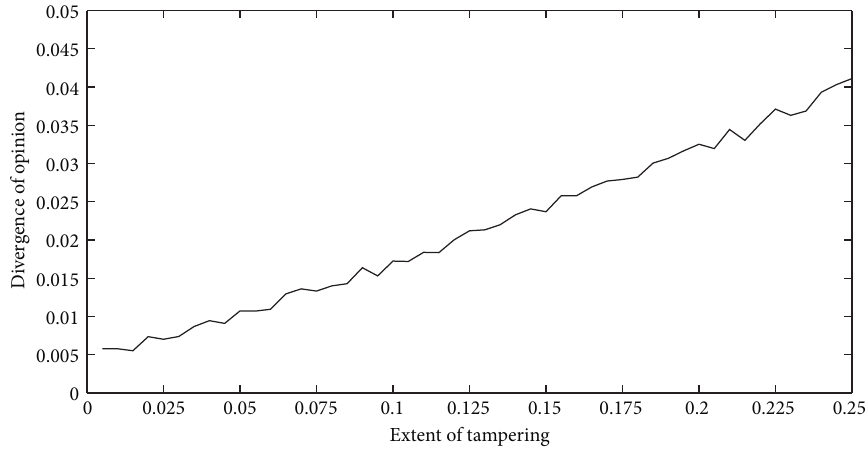
Figure 3: Divergence of group opinion with the extent of tampering.